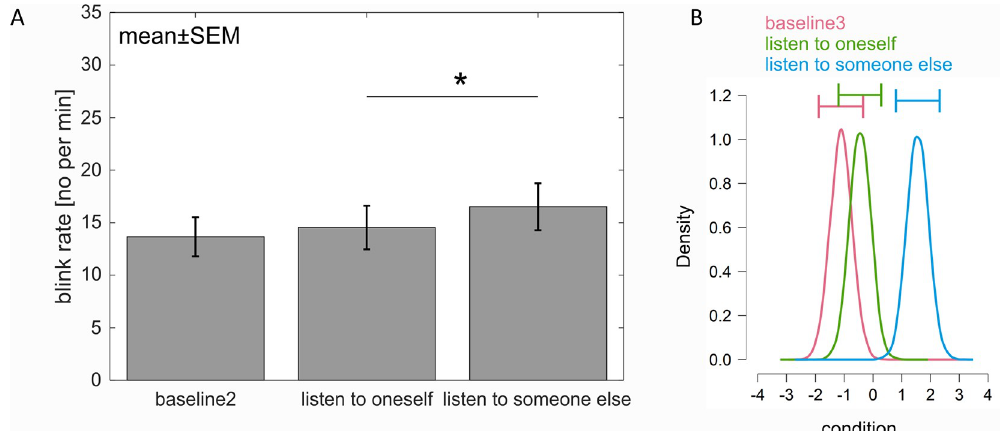
Fig 4. Influence of auditory input on the blink rate. A. Blink rate during the rest (“baseline 3”), “listen to someone else” and listening to a previously recorded monologue. Error bars represent one SEM. Stars mark significant differences revealed by parametric statistics. B. Posterior distributions of the effect of each condition on the blink rate. The blink rate between “listening to someone else” was not different to “baseline3”, but the blink rate between “listening to oneself” and”listen to someone else” was different. The horizontal error bars above each density represent 95% credible